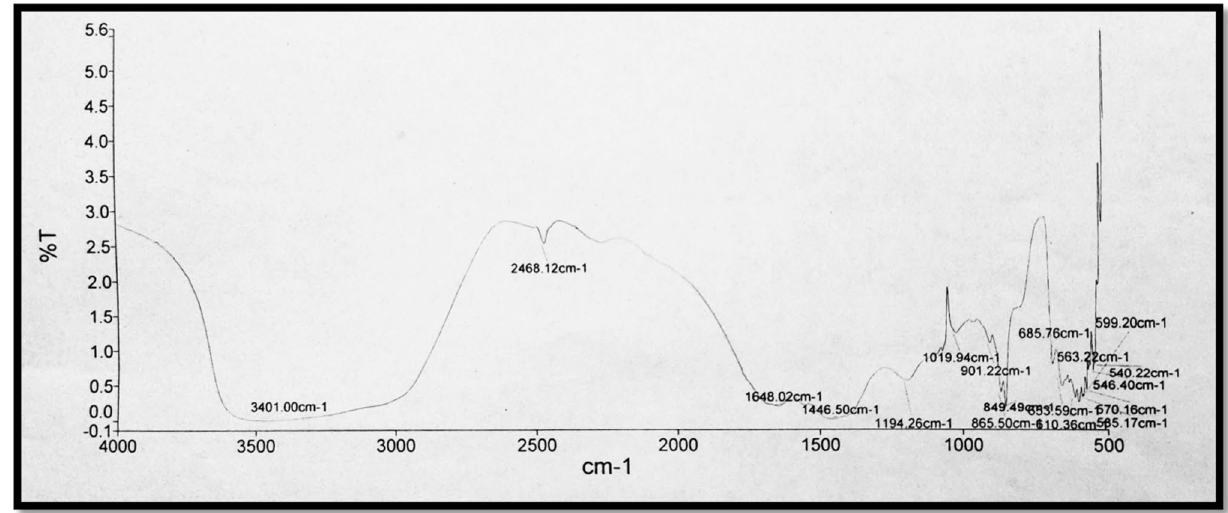
Fig. 3 FTIR Spectrum of aquatic fulvic